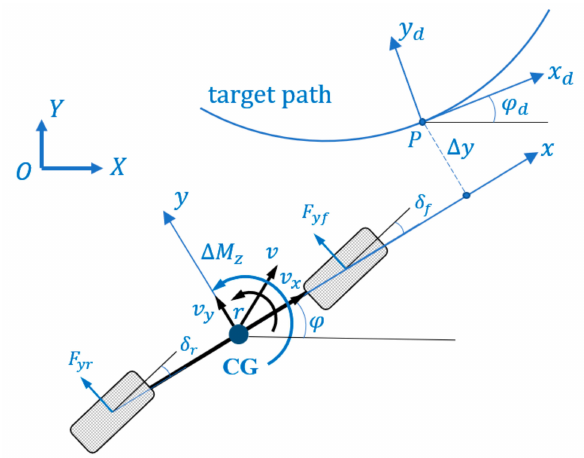
Figure 7. Path-tracking model for 4WID-4WIS